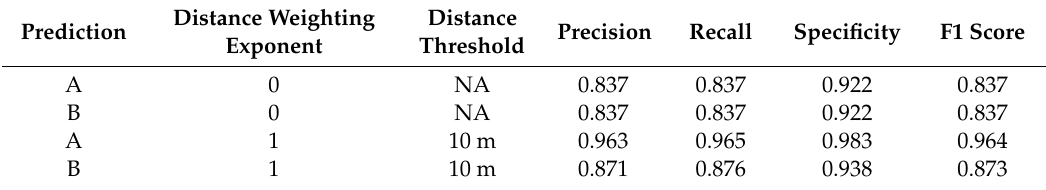
Table 3. Comparison of validation results for the synthetic features shown in Figure